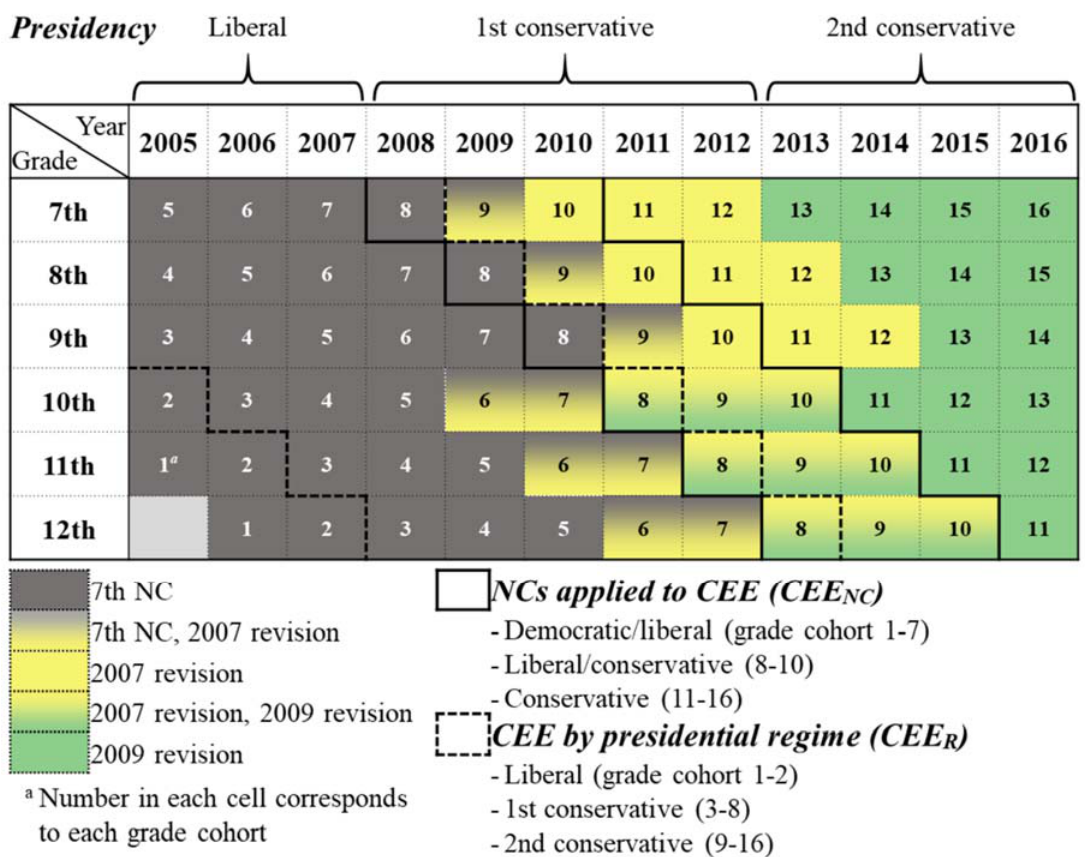
Figure 1. Political determinants and major suicide prevention policies in Korea. CEE, college entrance examination; NC, National Curriculum.